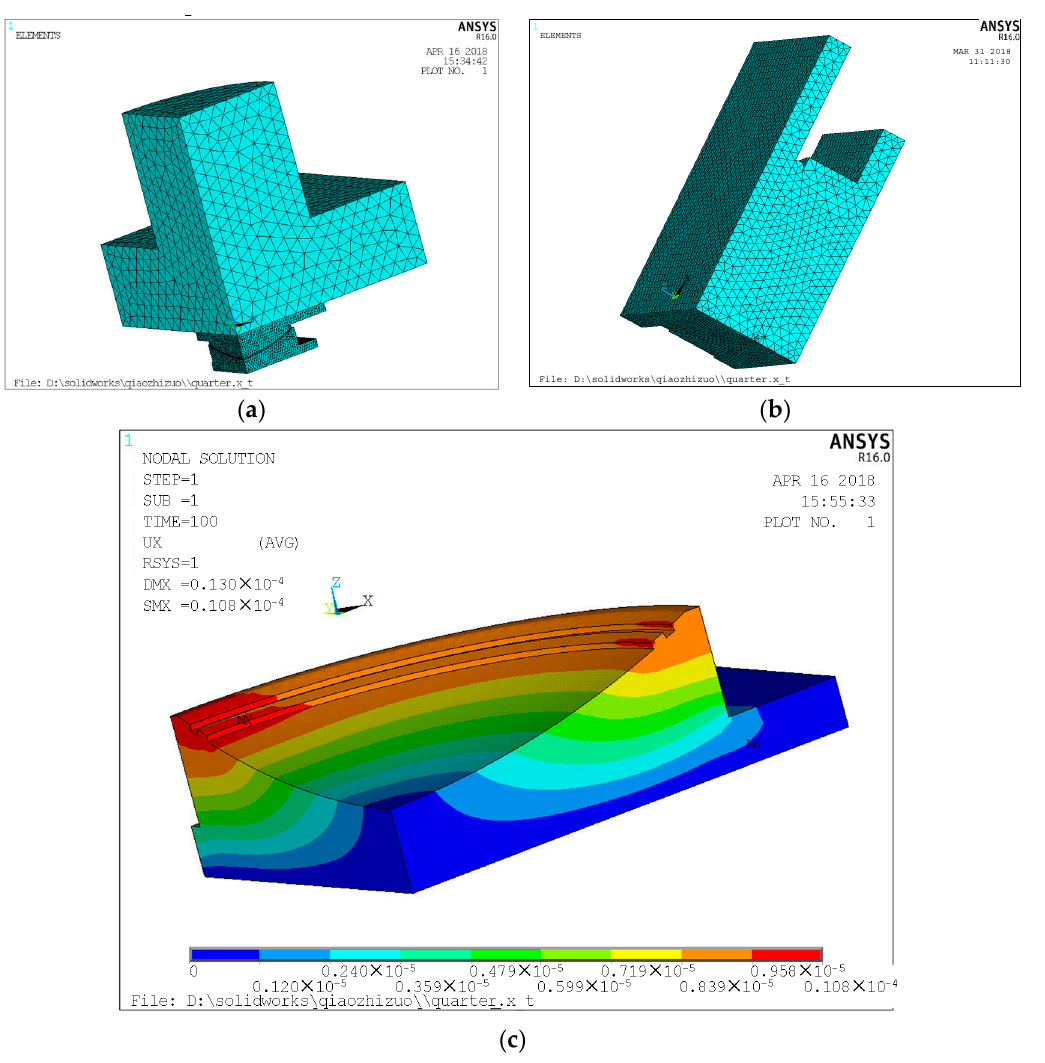
Figure 3. The finite element model and the analysis results. ( a ) The finite element model grid mesh division. ( b ) The grid mesh model of spherical bearing. ( c ) The finite element model analysis results. Table 1. The parameters of the designed finite element